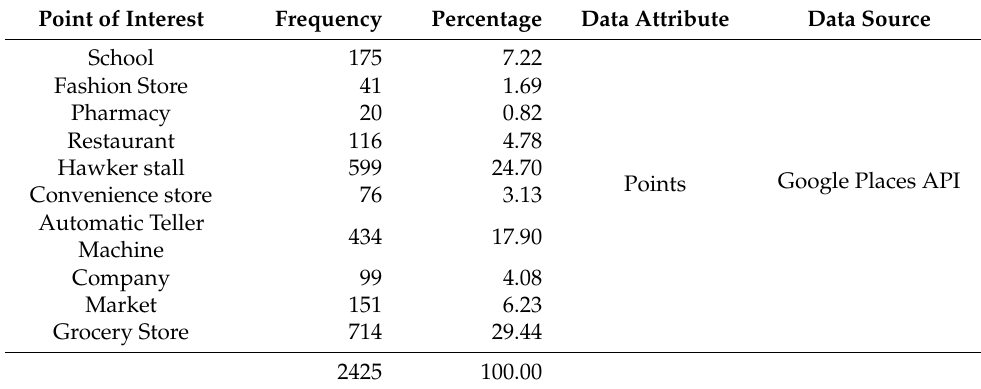
Table 2. Dependent variable or land value.